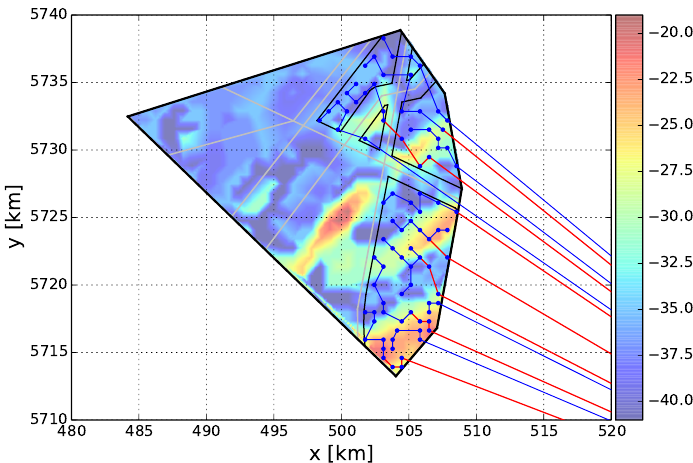
Figure 22. Layout with similar annual energy delivered (AED) and CAPEX values as the standard layout with Vestas 8 MW